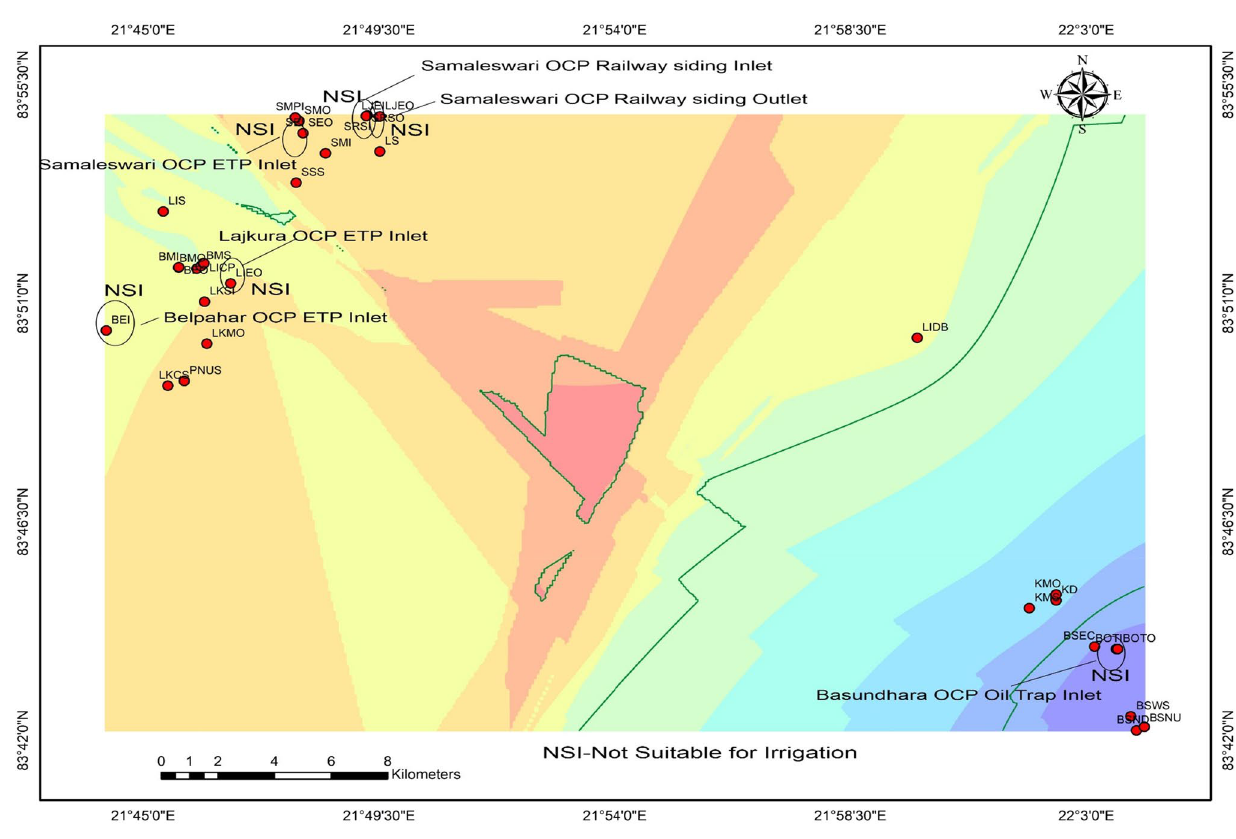
Fig. 16 Ib valley Coalfield map showing locations not suitable for Irrigation